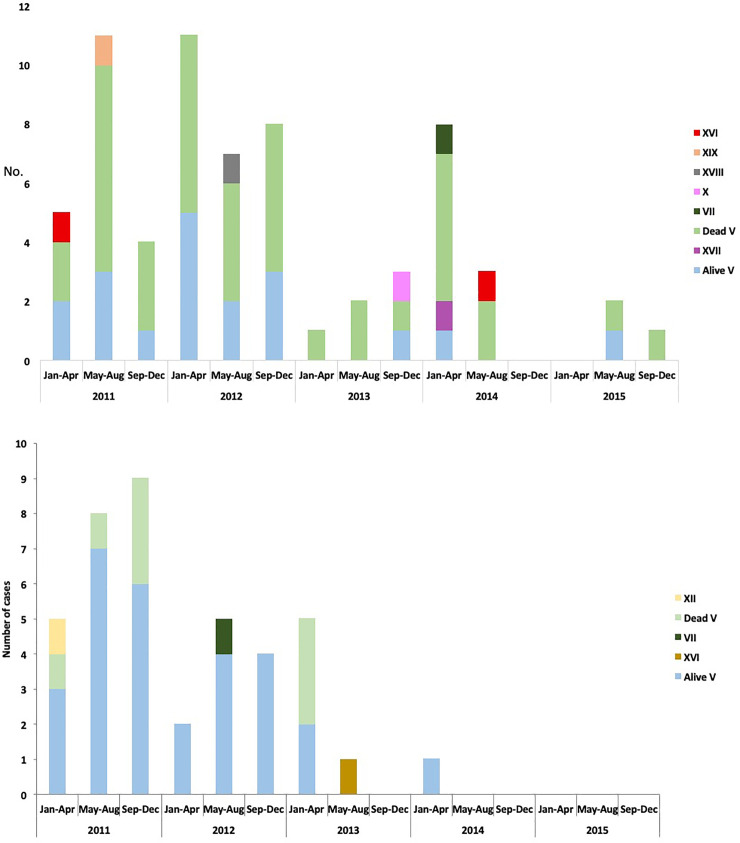
Number of infected (1a) and colonized (1b) patients during the study period (2011–2015) divided into alive or dead, including the plasmid profile.